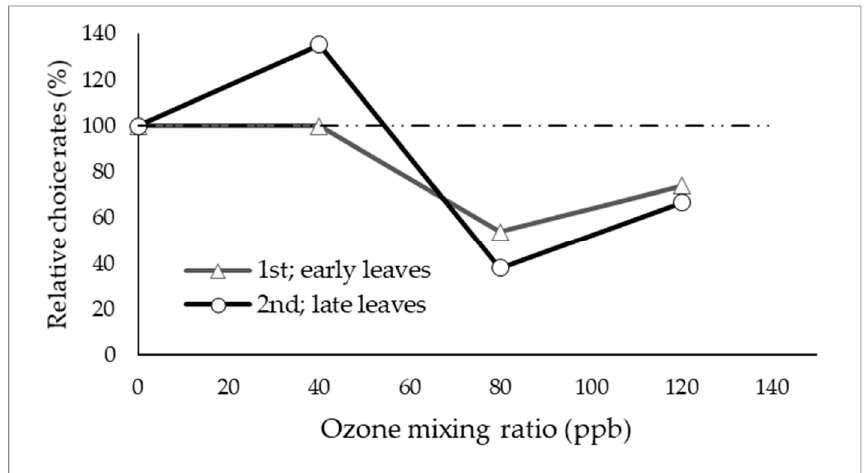
Figure 4. Relative choice rates versus biogenic volatile organic compounds (BVOC; emitted from leaves of white birch without O 3 mixture) of adult alder leaf beetles. First and second means first and second generation of adult leaf beetles, respectively. Each rate was calculated from data of (d,e) in Figure 3. Dashed line indicates theoretical rate (100%) in the case in which no BVOCs’ degradation occurs by O 3 . The biphasic response of insect choices to BVOCs mixed with O 3 cannot be considered a “hormetic response” [32] with certainty, because it may be solely upon changes in the atmospheric composition rather than changes in the leaf